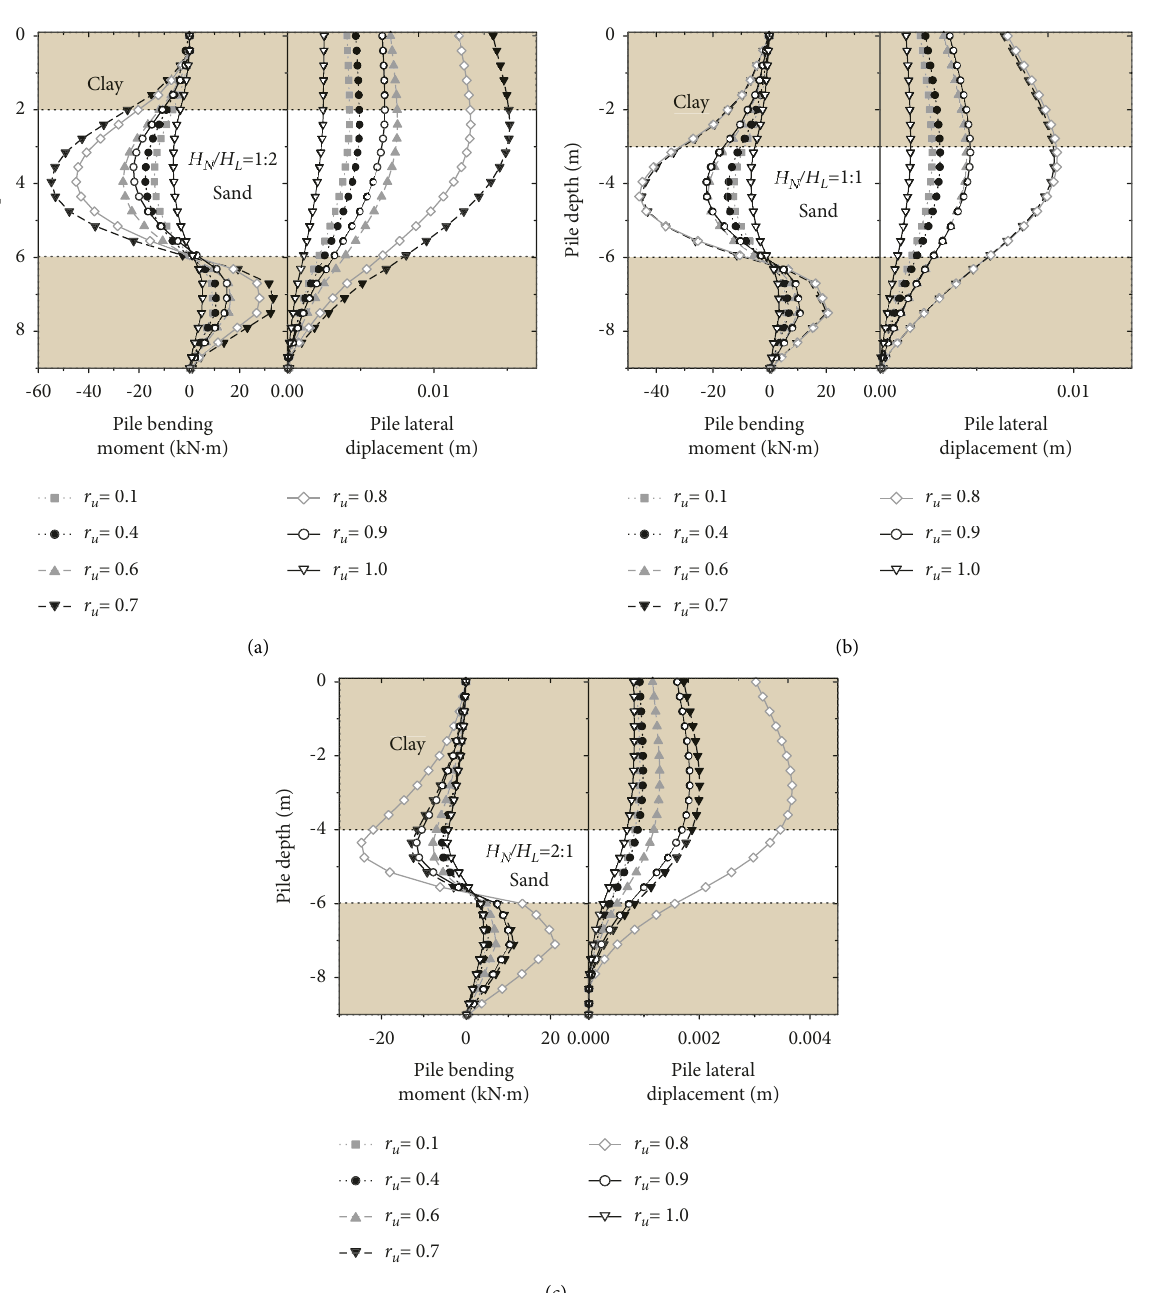
� 1: 2; (b) H N / H L : (a) H N / H L N /